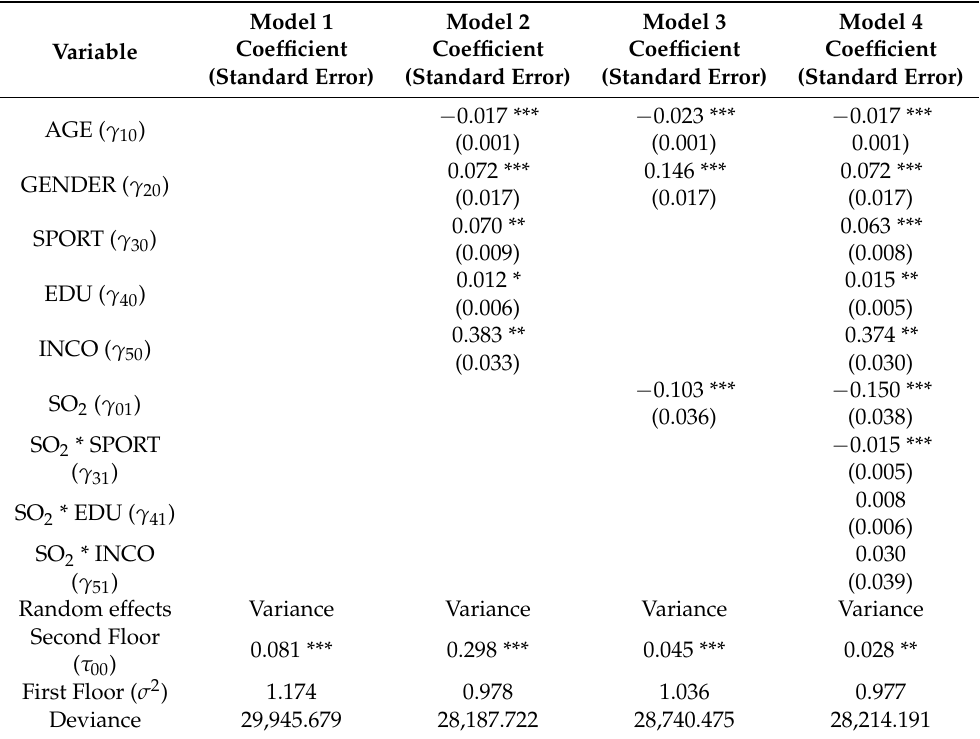
Table 2. Results of multilevel analysis of the health effects of air pollution on